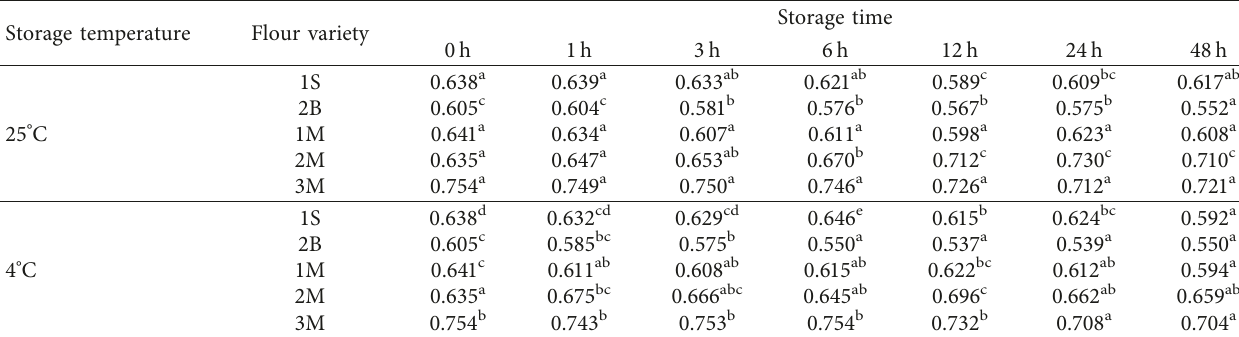
Table 3: Springiness of fresh wet noodles made from different flours during storage.